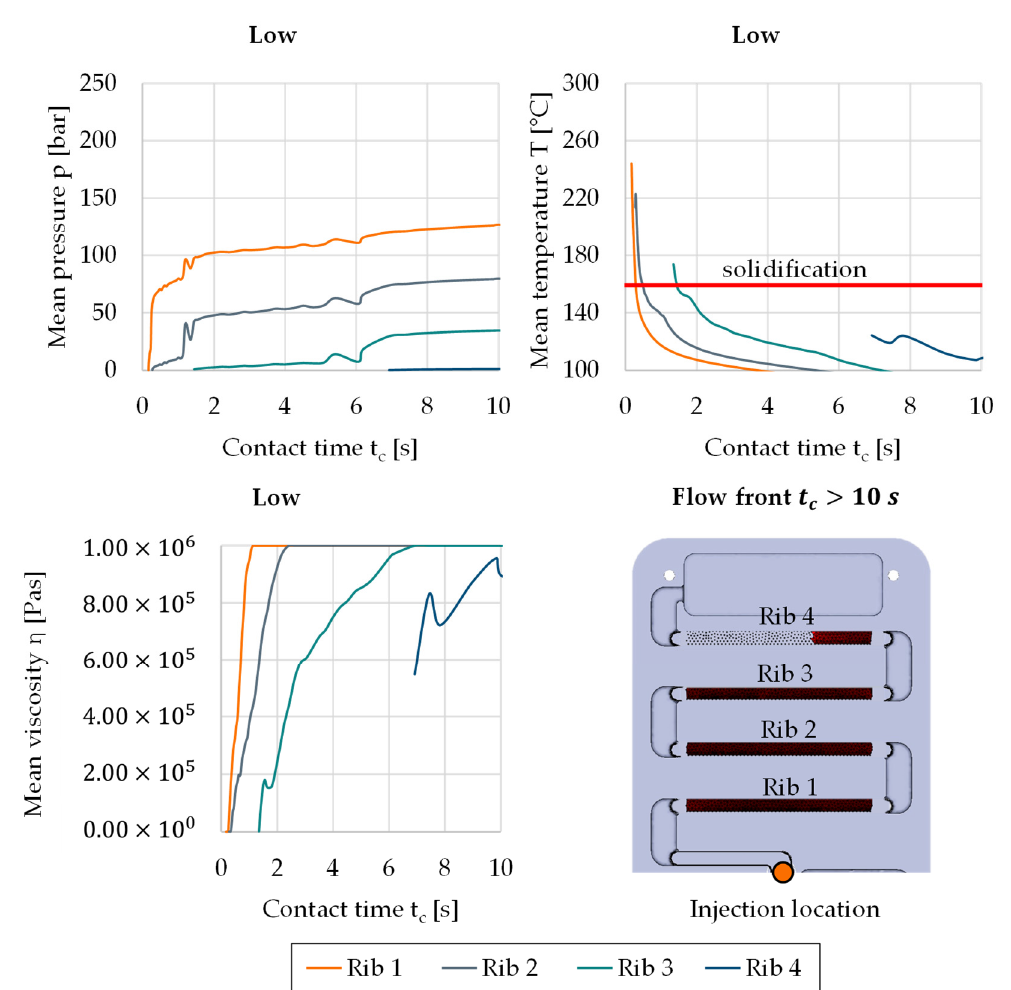
Figure 9. Results of the injection moulding simulation for the process parameter set “Low” for individual ribs of the cross-tension test specimen and final flow front after overmoulding process.